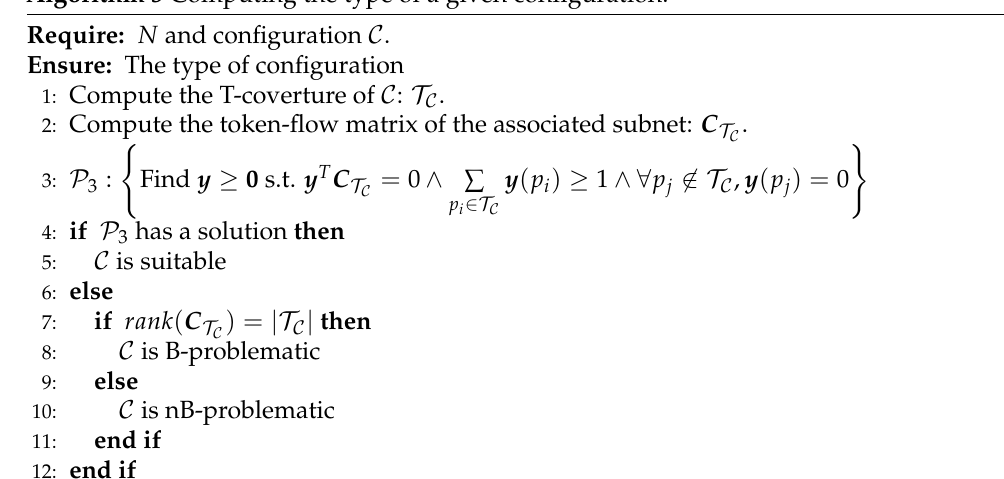
Algorithm 3 Computing the type of a given